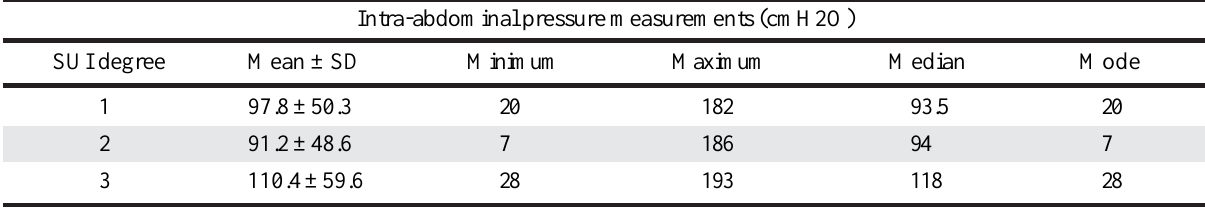
TABLE 3 - Distribution of IAP measurements on perineal ultrasound of women with a barely empty bladder according to the degree of SUI.